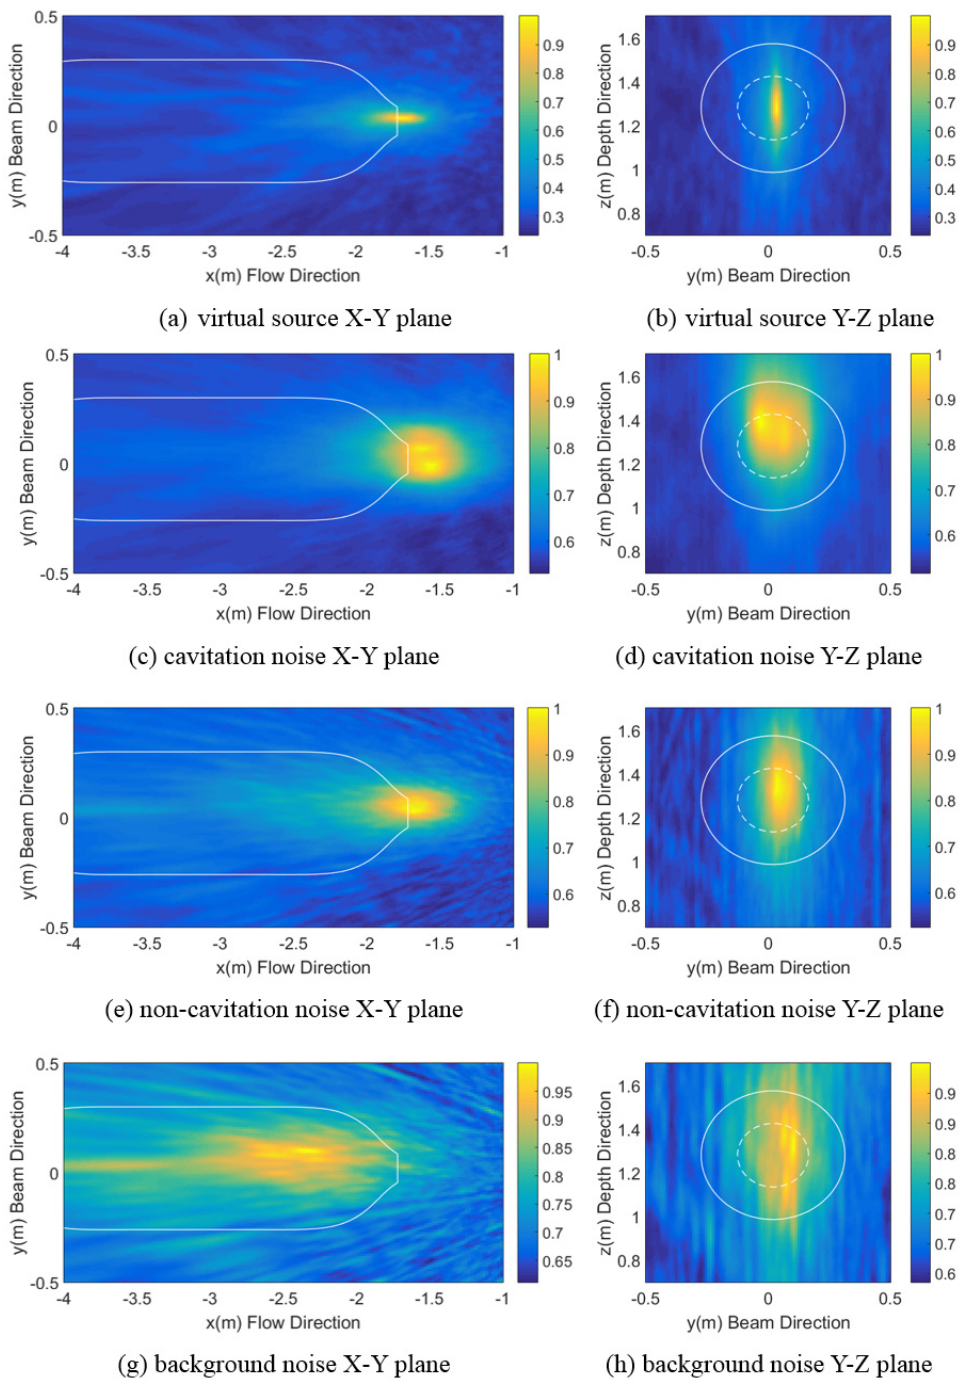
Figure 19. Ambiguity surfaces (x-y plane and y-z plane) of the virtual source ( a , b ); propeller cavitation noise ( c , d ); non-cavitating propeller noise ( e , f ) and background noise ( g , h ); at the depth and the range of the maximum processor power. In each plot, the white line represents the outline of the body, and the dashed circle is an imaginary disc of which the radius is the same as the propeller.